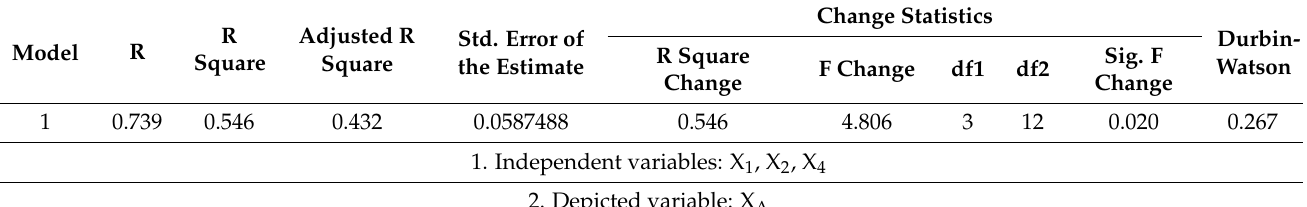
Table 7. Summary of developed model with three predictors.